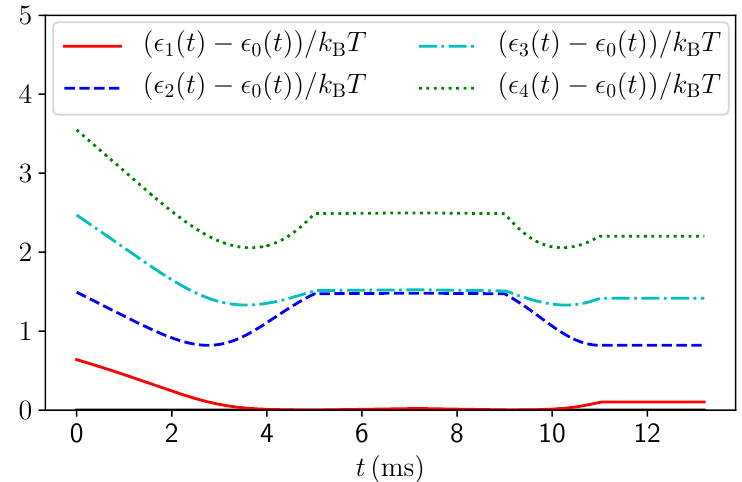
( t ) of the lowest eigenstates of the transverse j ( t ) , in units of k T , B 0